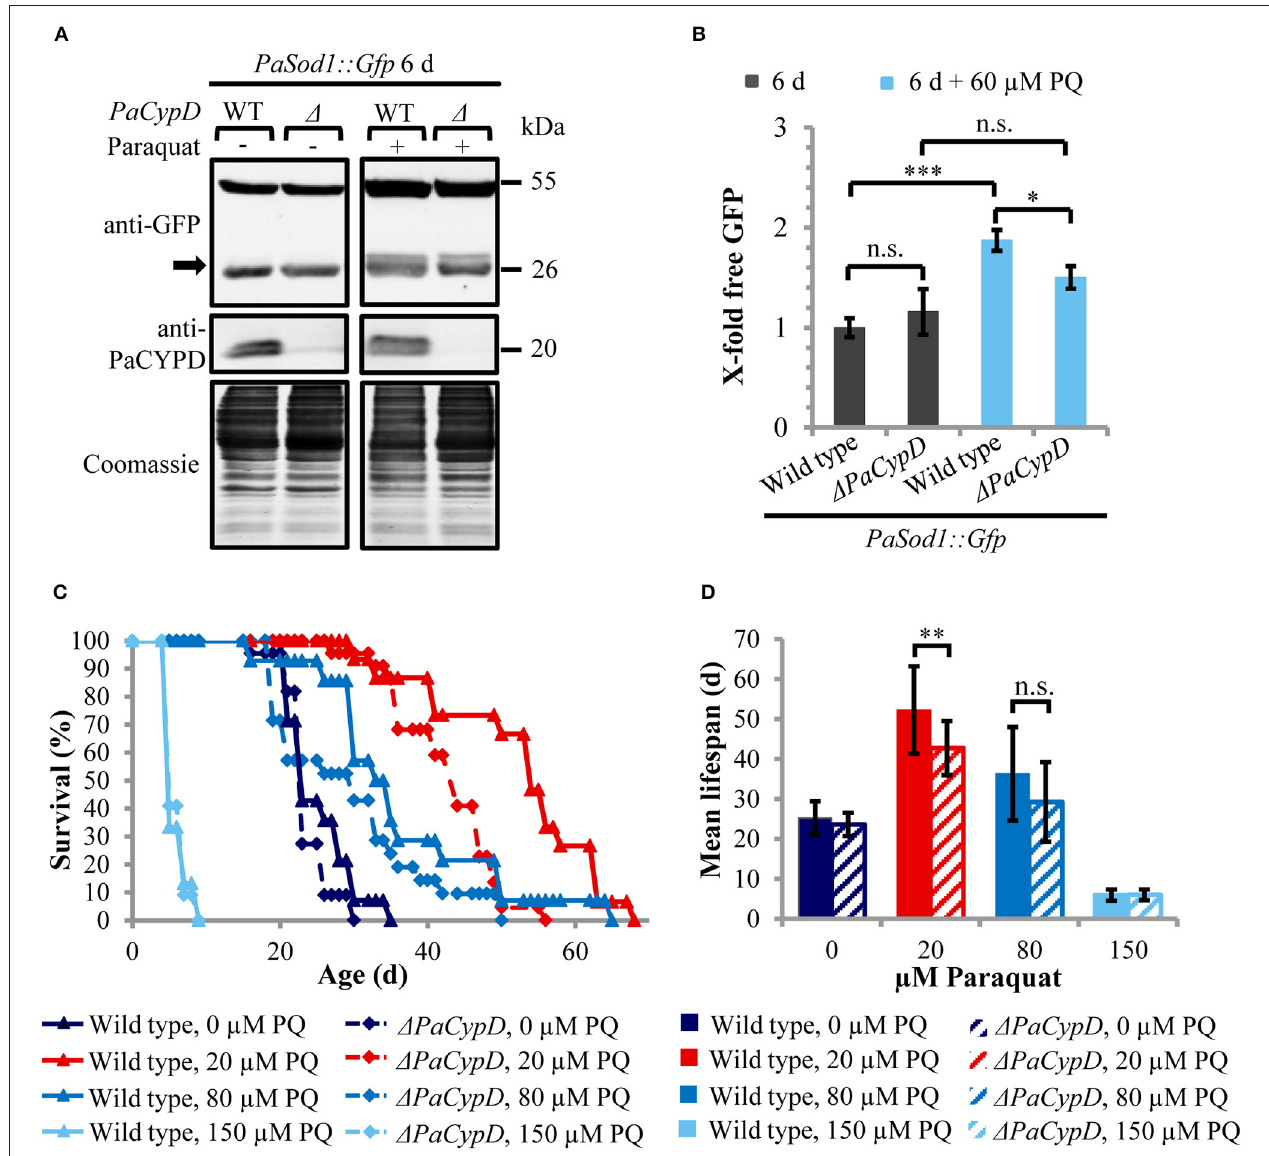
FIGURE 4 | PaCYPD mediates autophagy and participates in longevity-assurance under ROS stress. (A) Monitoring autophagy by western blot analysis using the cytosolic protein PaSOD1::GFP. 6 d old wild-type (WT) and ∆ PaCypD strains expressing PaSod1::Gfp were cultured for 2 d in CM medium with or without 60 µ M paraquat (PQ). “Free GFP” (indicated by arrow) and PaCYPD was detected by immunoblotting with anti-GFP and anti-PaCYPD in 100 µ g total protein extracts. The positions of molecular mass markers are indicated on the right. (B) The GFP protein levels of three different isolates of each strain were normalized to the Coomassie-stained gels (loading control) and the protein amount present in the 6 d old wild type was set to one. Data represent average ± SEM (2-tailed student’s t- test), not significant (n.s.), * P < 0.05, *** P < 0.001. (C) Lifespan and (D) mean lifespan of at least 14 different isolates of the wild-type strain and at least 21 different isolates of the ∆ PaCypD strains on M2 medium in the presence of 0, 20, 80, or 150 µ M paraquat (PQ). Data represent average ± SEM (2-tailed Wilcoxon rank-sum test) Not significant (n.s.), ** P < 0.01. At note: Survival curves of wild type and ∆ PaCypD in presence of 150 µ M PQ are largely overlapping and therefore difficult to